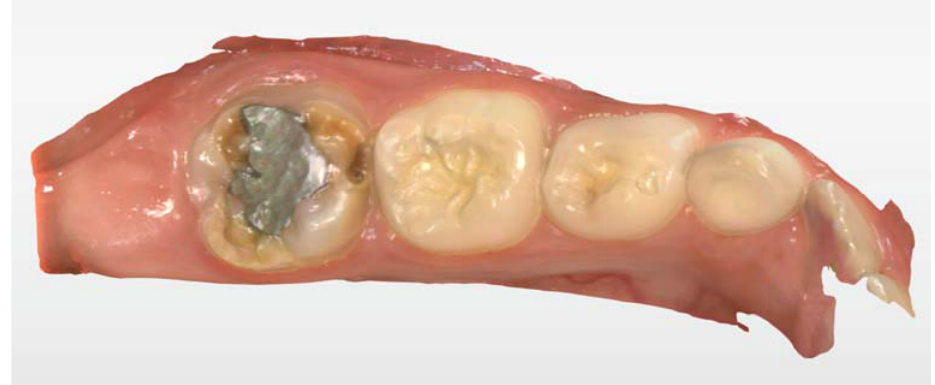
Figure 2. A scan of tooth #36 before tooth preparation.